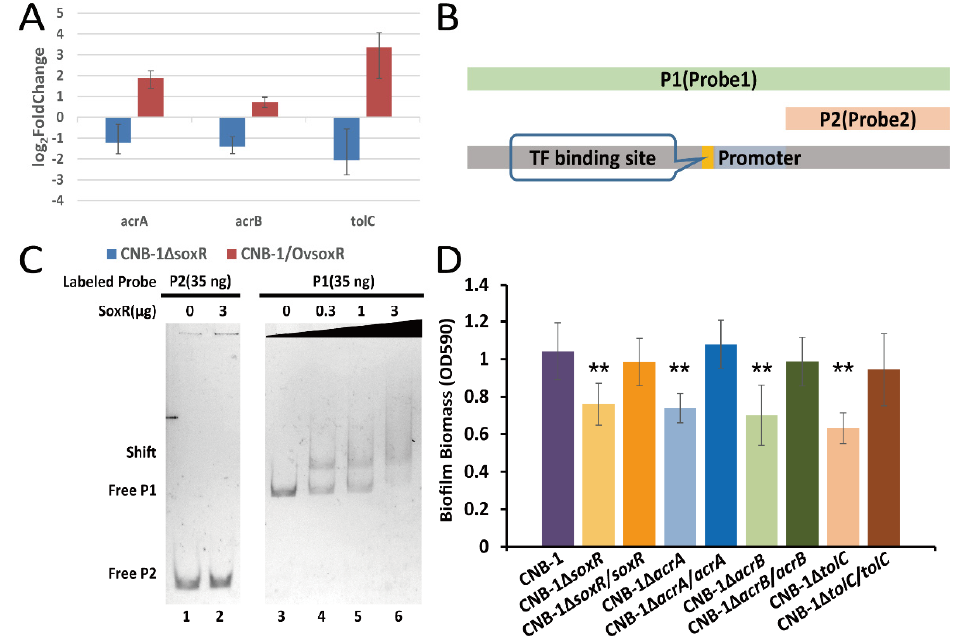
Figure 3. SoxR positively regulates the transcription of the acrAB-tolC operon in C. testosteroni . ( A ) Transcriptional changes in acrA , acrB , and tolC in soxR -deleted and soxR -overexpressing strains. ( B ) Diagram of probes for the gel shift assay. ( C ) Determination of the interaction between SoxR and acrAB-tolC operon DNA. Probe2 used as the negative control lacked predicted transcription factor binding sites and a promoter. From lanes 3 to 6, the number of Probe1 binding to proteins (shift band) increased with an increase in SoxR concentration. ( D ) Biofilm formation in acrAB-tolC operon components-deleted and -complemented mutant strains was assessed using a crystal violet assay. The effect of SoxR on acrAB-tolC gene transcription was consistent with that on biofilm formation. Data in panel D are the means and standard deviations from three independent experiments conducted in triplicate. (** p < 0.01 with Student’s t -test.).